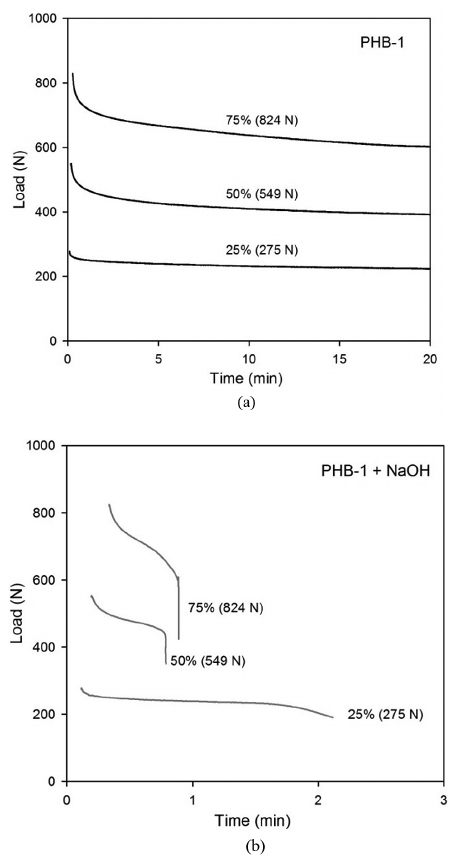
Figure 8. Time to failure of PHB-1 and PHB-2 as a function of